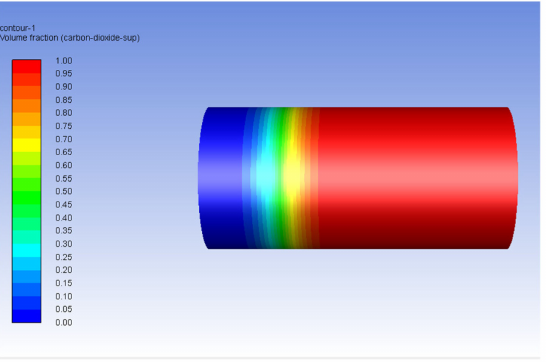
Figure 15. Carbon dioxide volume fraction after 10 s at inlet pressure of 10.1 MPa.